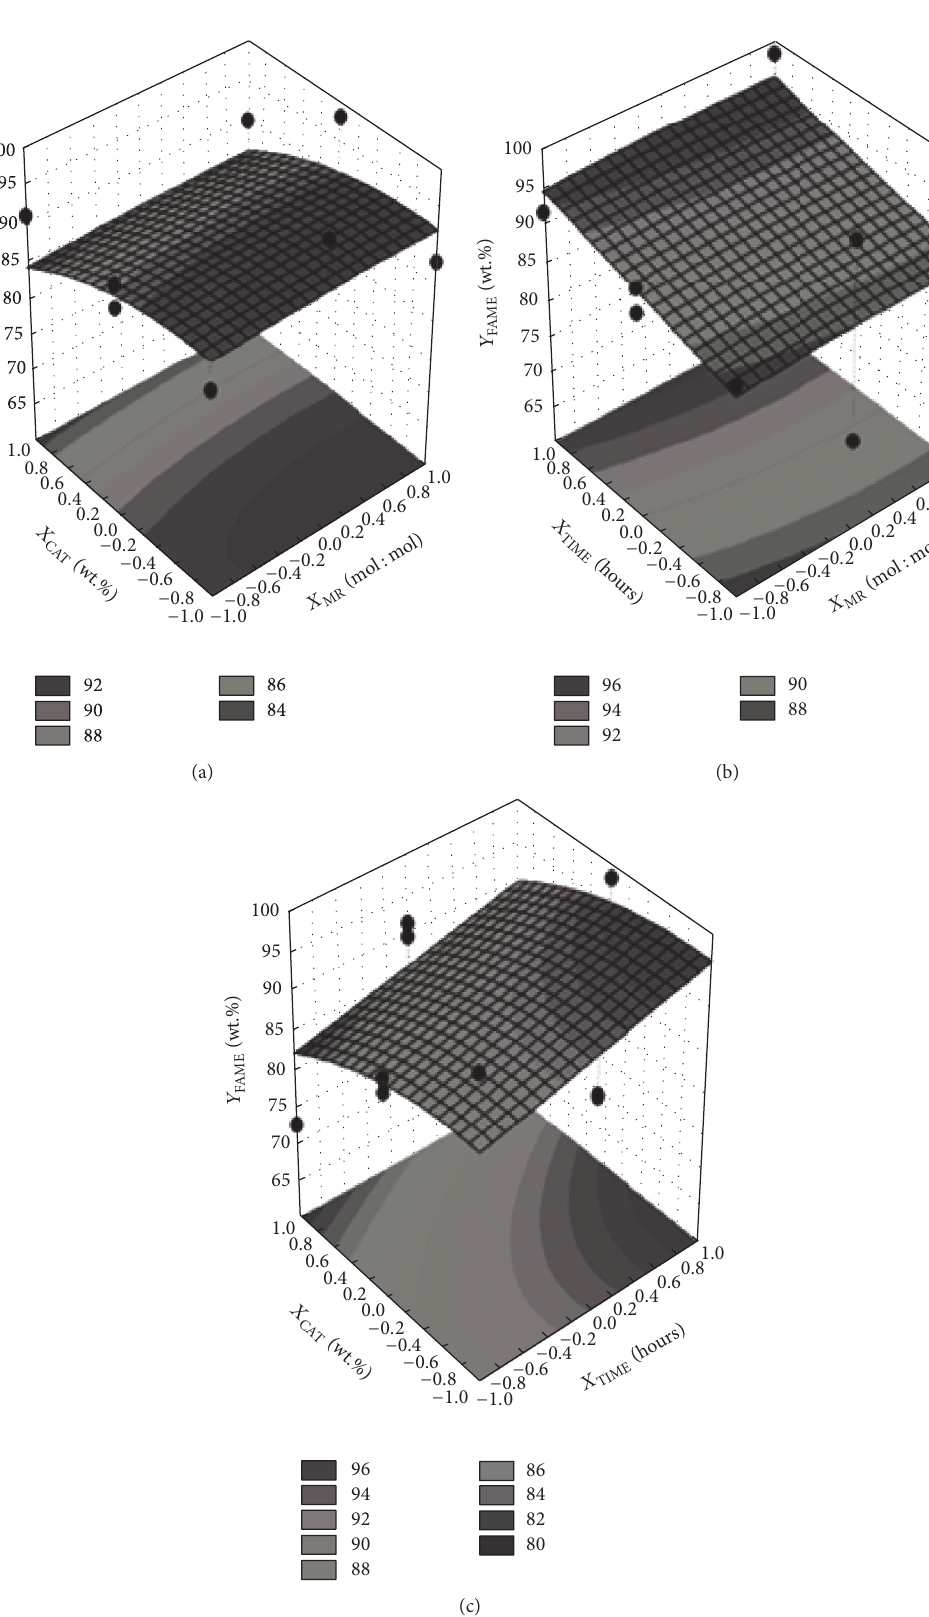
Figure 5: Response surface for model of quail eggshell